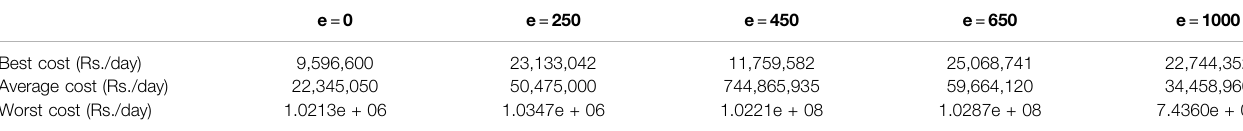
TABLE 3 | For 1,000 test runs using the ANN-GA algorithm, objective output was measured using different weight values. e = 0 e = 250 e = 450 e = 650 e = 1000 Best cost (Rs./day)